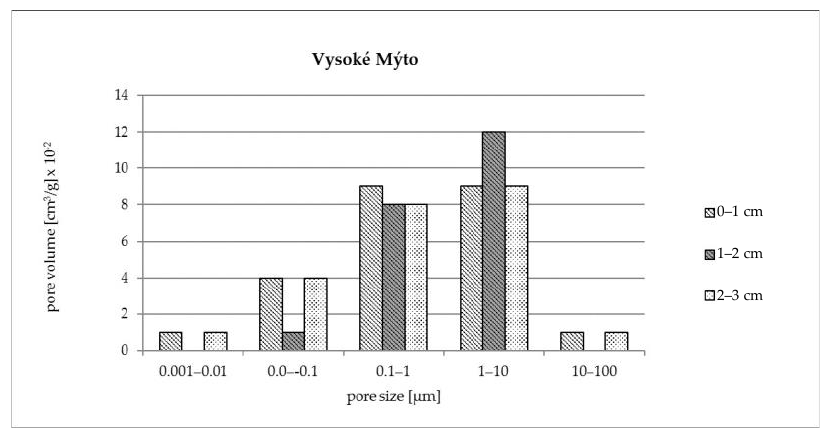
Figure 2. Pore size distribution of individual layer of the brick: Vysoké Mýto (0 – 1 cm, 1 – 2 cm, 2 – 3 cm from the cover).